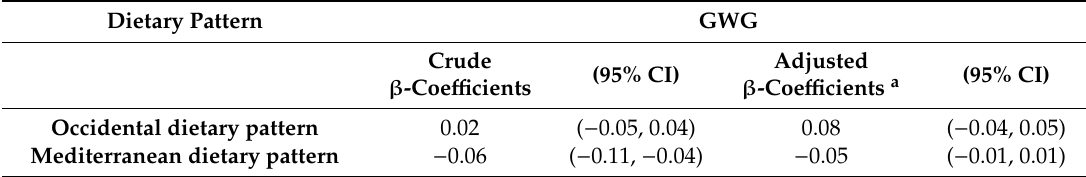
Table 4. Multivariable regression models for the association between dietary patterns and gestational weight gain (GWG) ( n = 503). Dietary Pattern GWG Adjusted Crude (95% CI) (95% CI) β -Coe ffi cients a β -Coe ffi cients Occidental dietary pattern 0.02 Mediterranean dietary pattern − 0.06